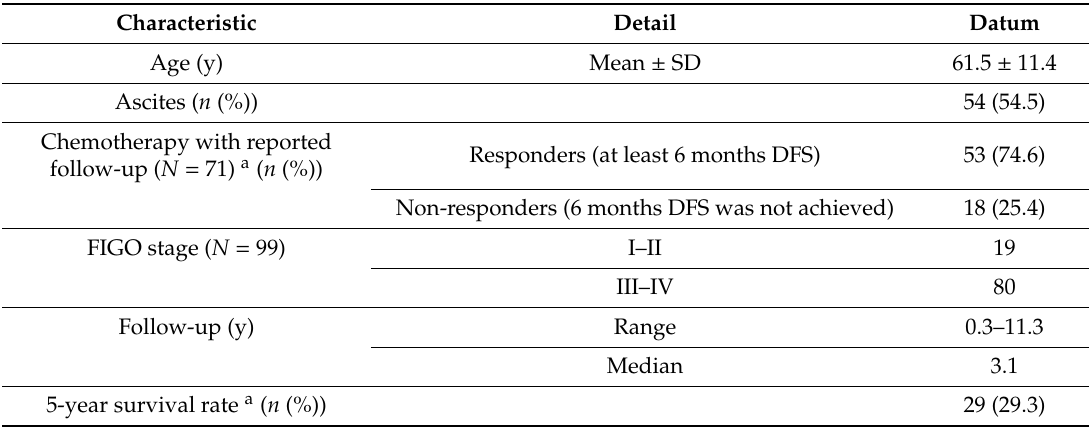
Table 2. Clinical and histopathological data of HGSC